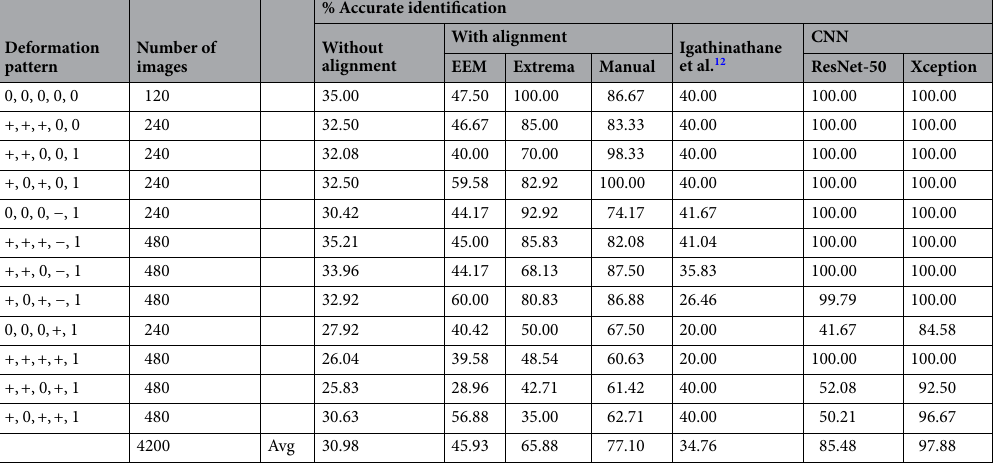
Table 1. Accuracies of various shape identification algorithms. EEM = equivalent ellipsis